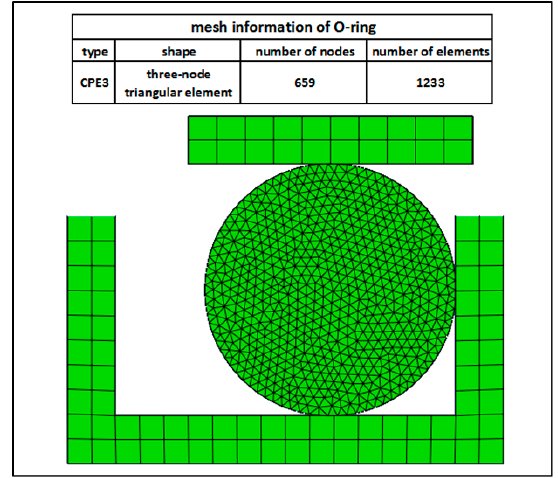
Figure 6. Finite element model of the O-ring.